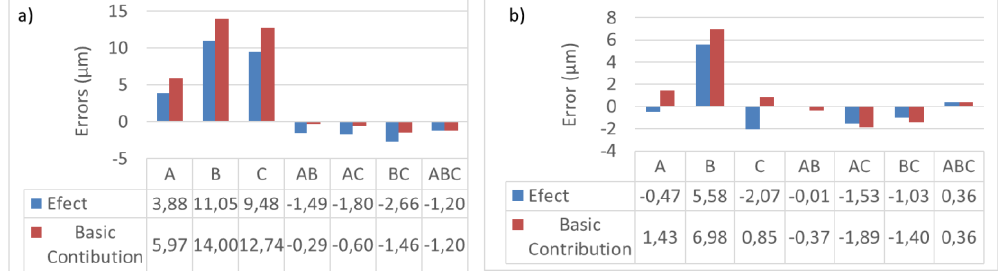
Figure 9. Effect and basic contribution of point distribution, number of points and number of tests on maximum error ( a ) and average error ( b ).